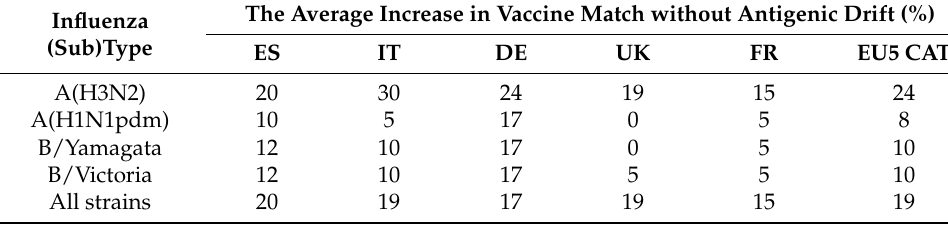
Table A3. Country-level and EU5-level survey responses on the influenza VM increase without antigenic